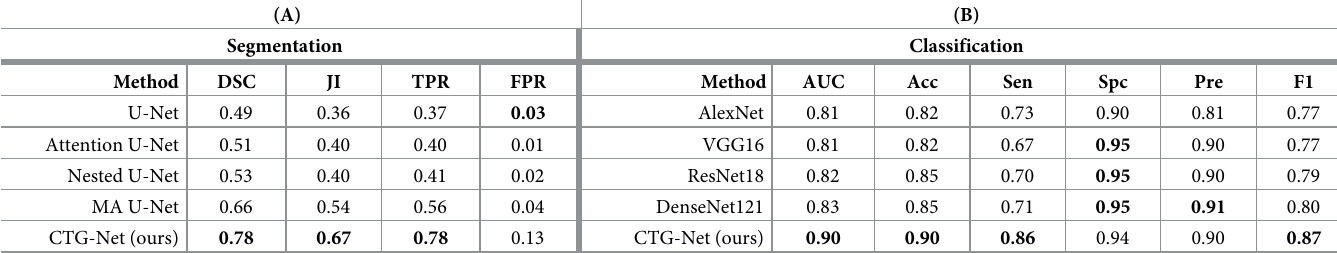
The best results are indicated in boldface.